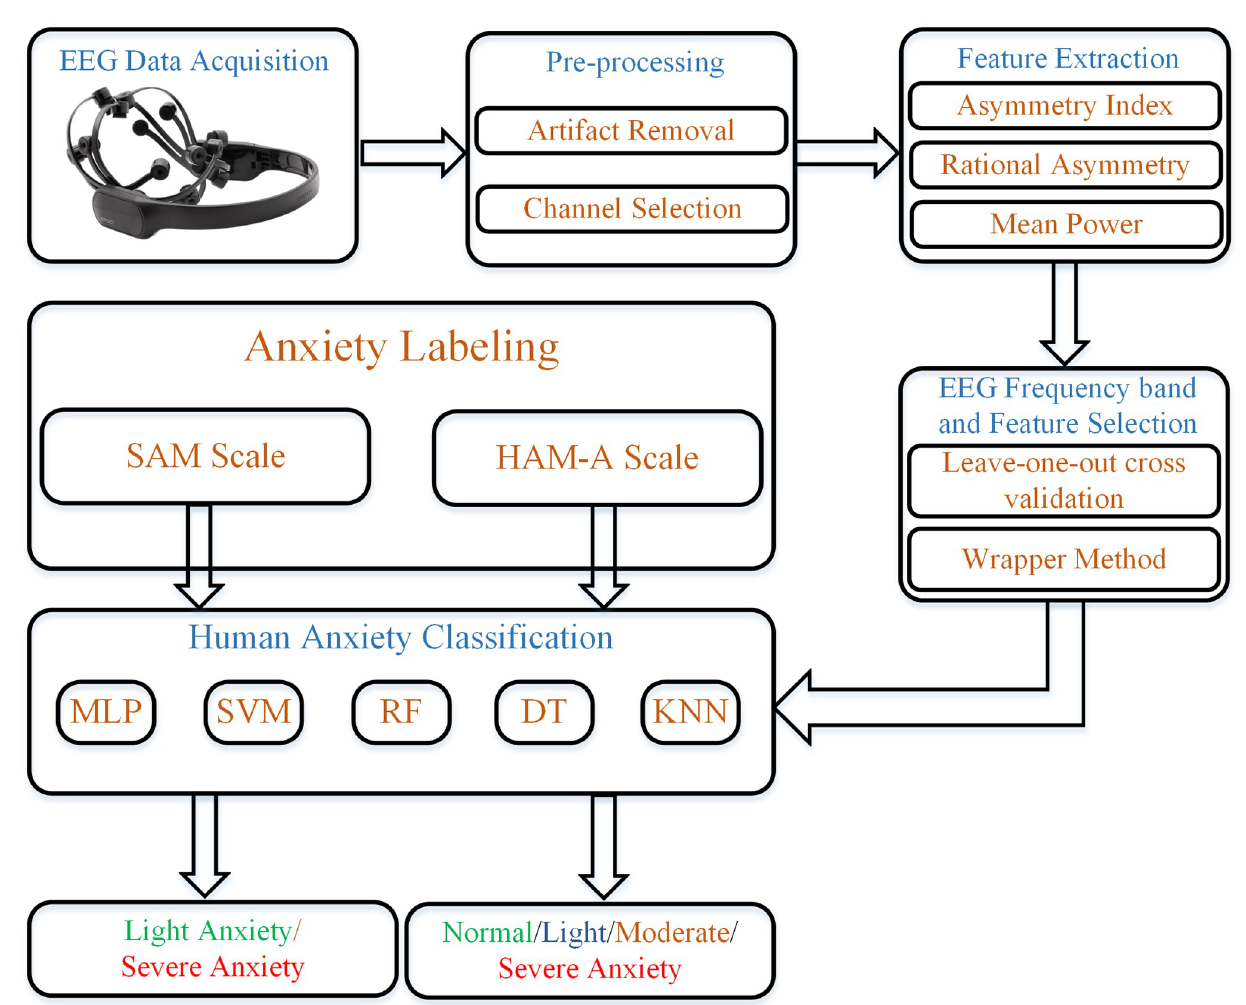
Fig 1. Block diagram of the proposed human anxiety classification scheme in response to exposure